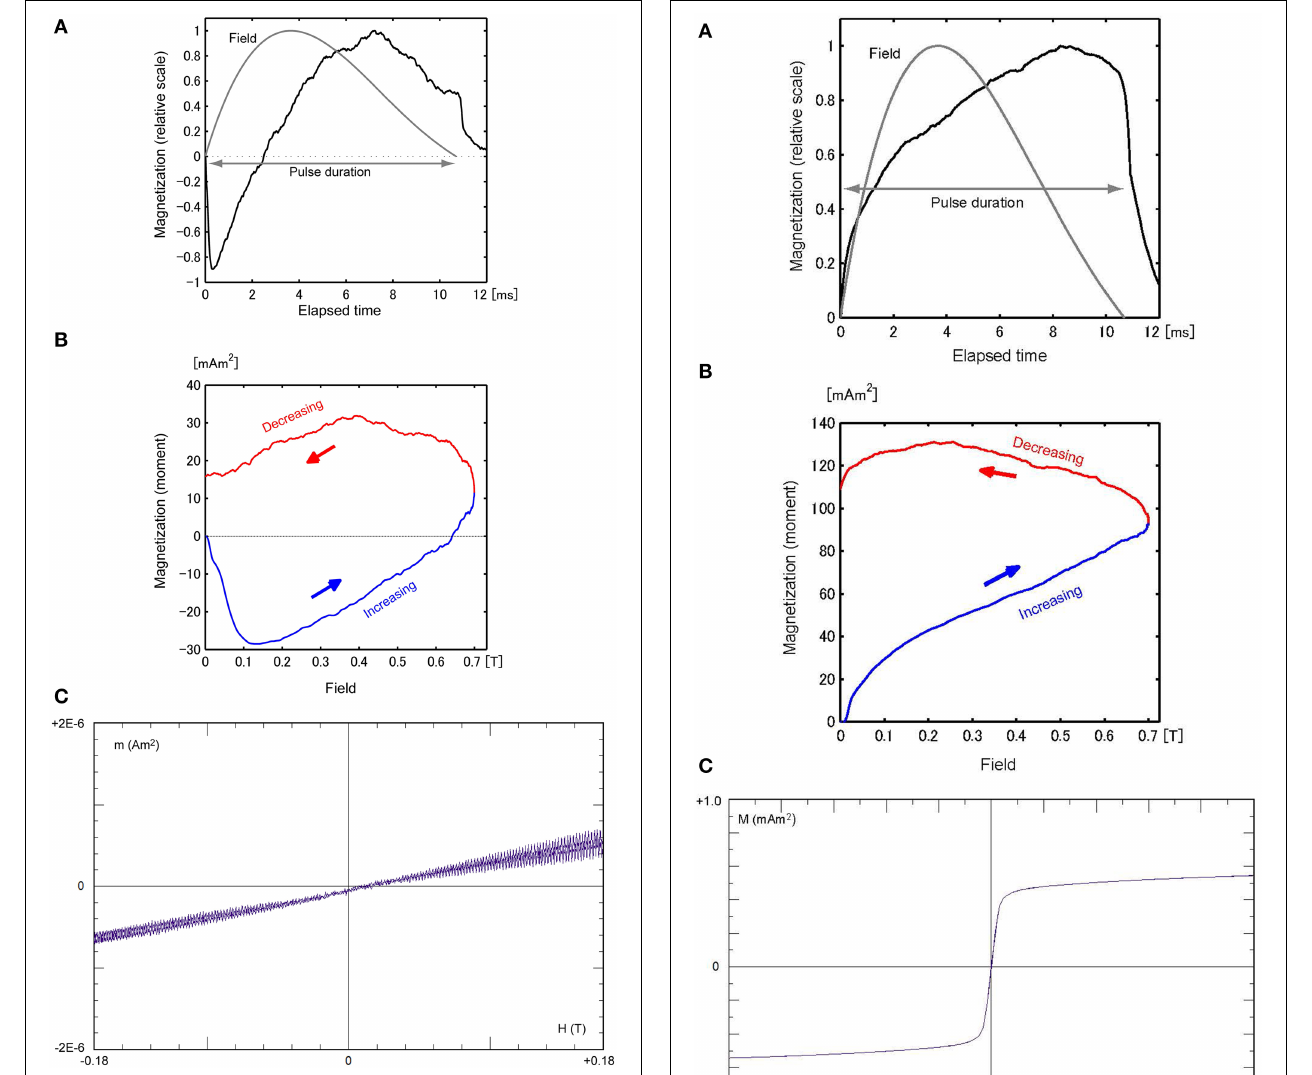
FIGURE 4 | (A) M–t curve of sample Al, scaled to the maximum magnetization (32mAm 2 ). The H–t curve (gray), scaled to the peak value of 0.7 T, is provided for comparison. (B) M–H curve for the increasing field (blue) and reducing field (red). (C) VSM result of Al (26.7 mg). FIGURE 5 | (A) M–t curve of sample PL, scaled to the maximum